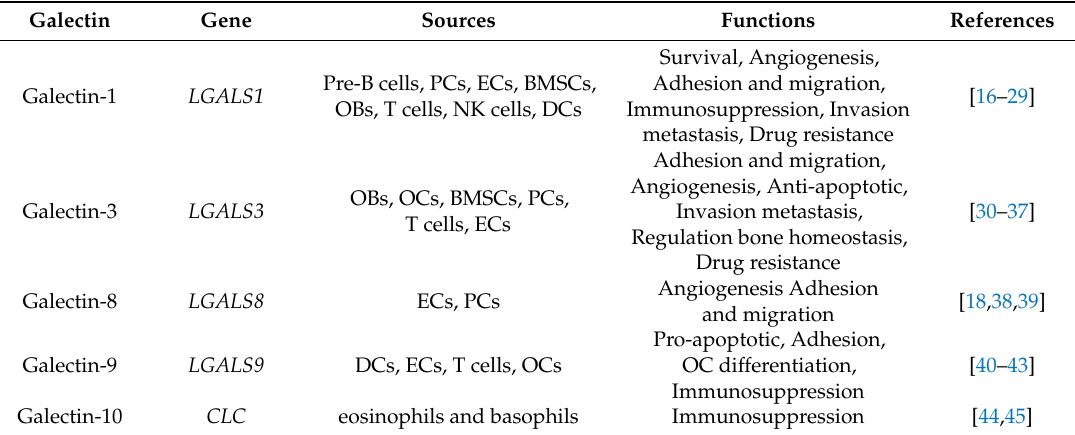
Table 1. Sources and functions of the mains